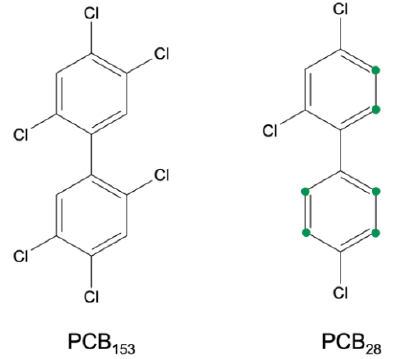
Figure 4. Availability of different PCBs chemical structure for aerobic